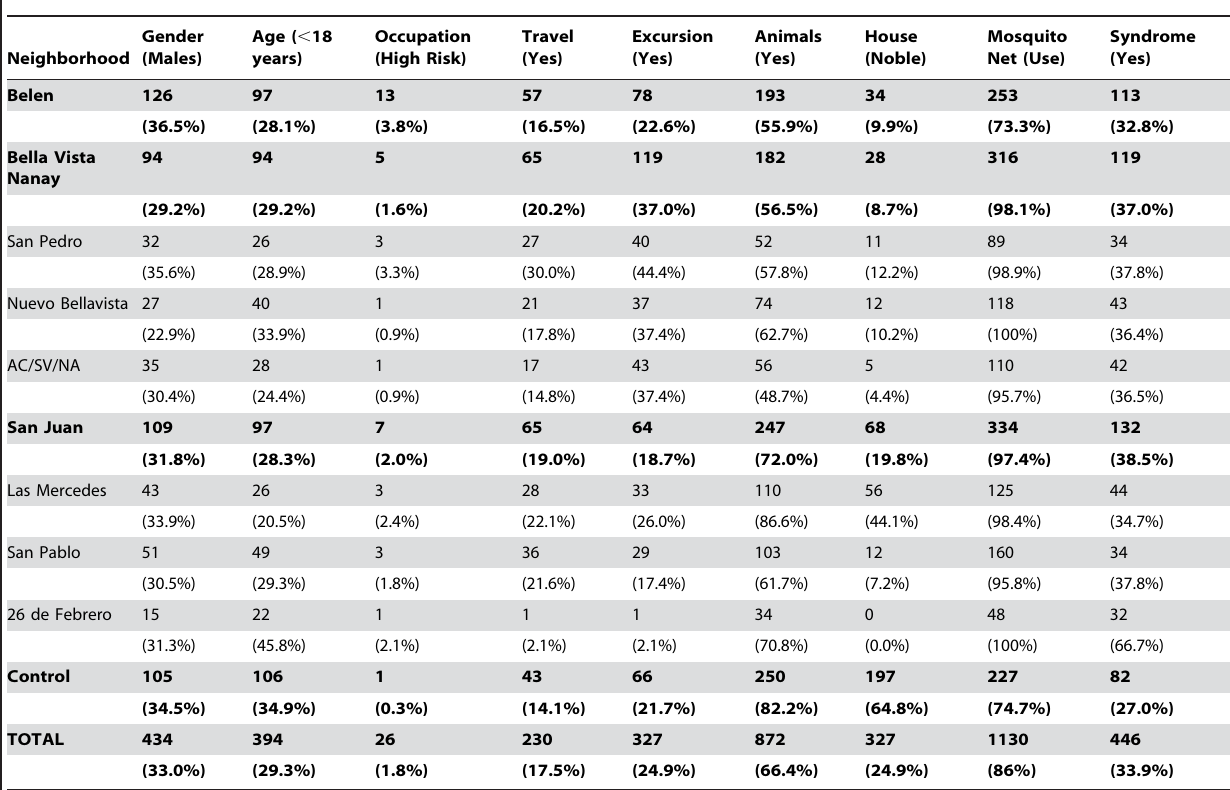
Table 3. Characteristics of 1,314 subjects living in three neighborhoods reporting VEEV cases between January and June, 2006, and 22 blocks previously included in Dengue cohort